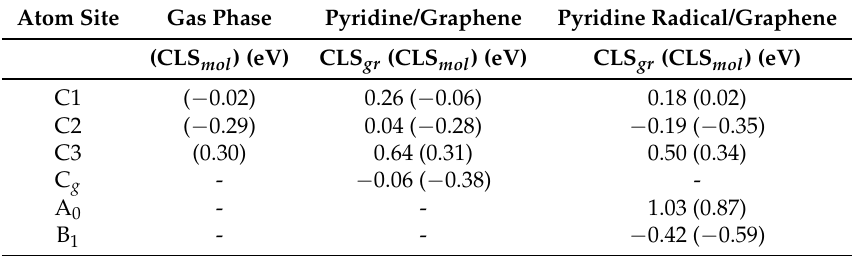
Table 1. The CLS with respect to the C atoms of the molecule is tabulated for gas phase pyridine along with the CLS with respect to graphene (molecule) for the two cases: pyridine/graphene and pyridine radical/graphene. The CLSs for a few selected atoms of graphene as specified in Figure 1 are also